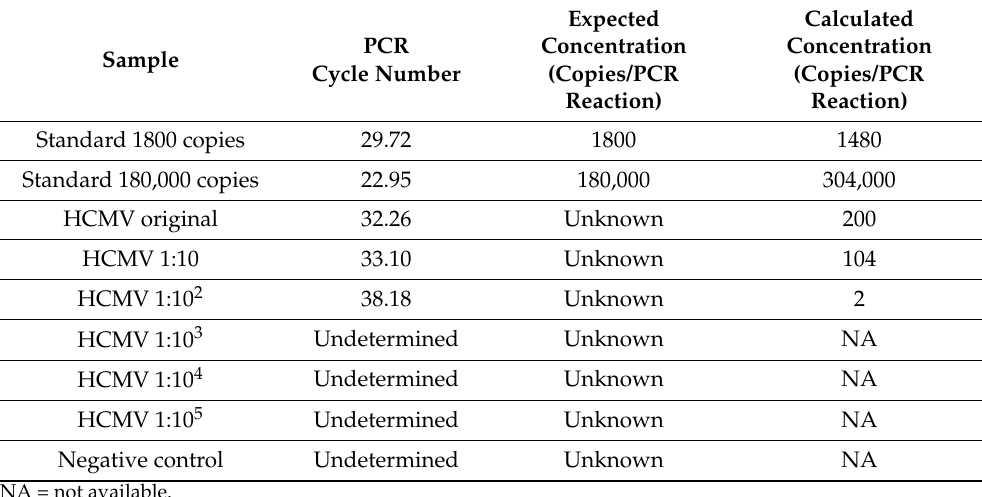
Table 1. HCMV positive control was prepared in serial dilutions ranging from 1 to 1:10 5 . The samples were examined for the presence of HCMV gB DNA using LC-PCR.